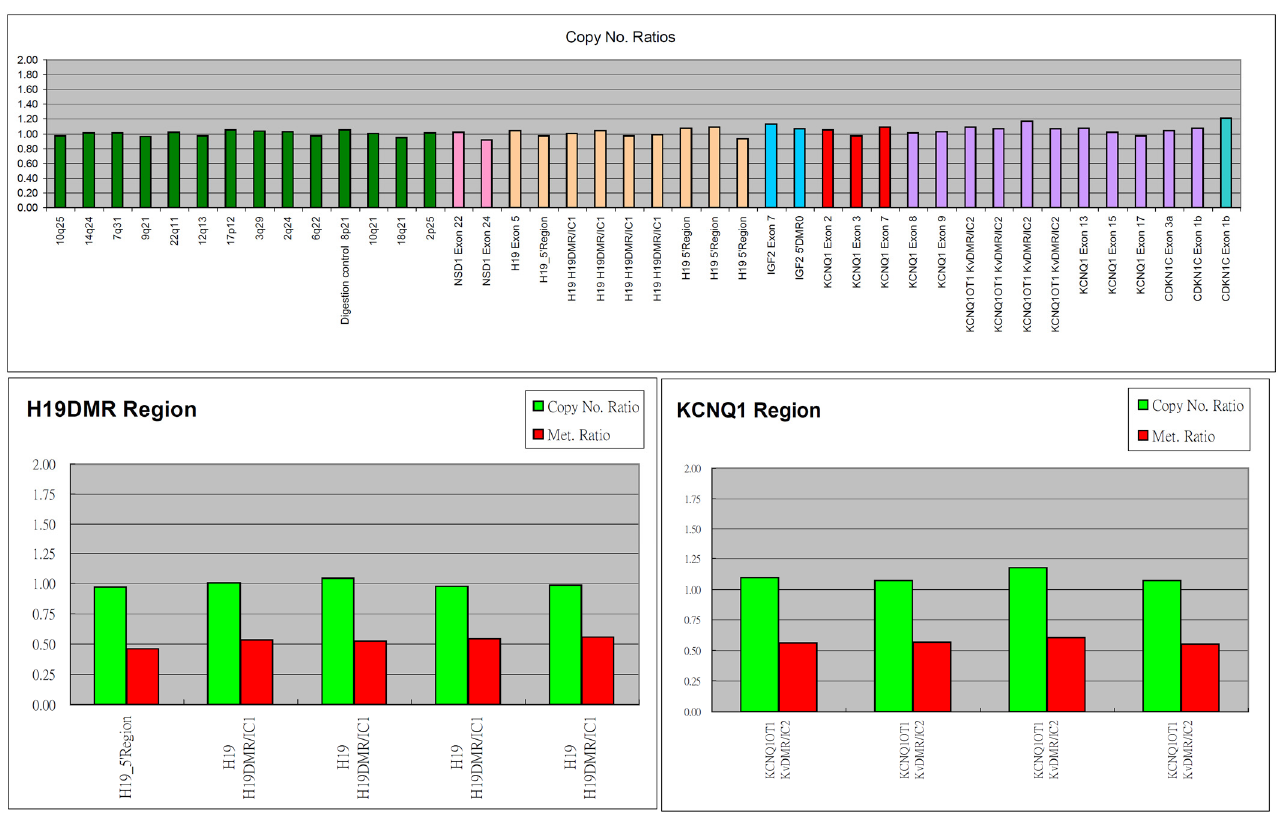
Figure 5. Multiplex ligation-dependent probe amplification (MLPA) of amniotic fluid showed normal methylation of BWS/RSS region.